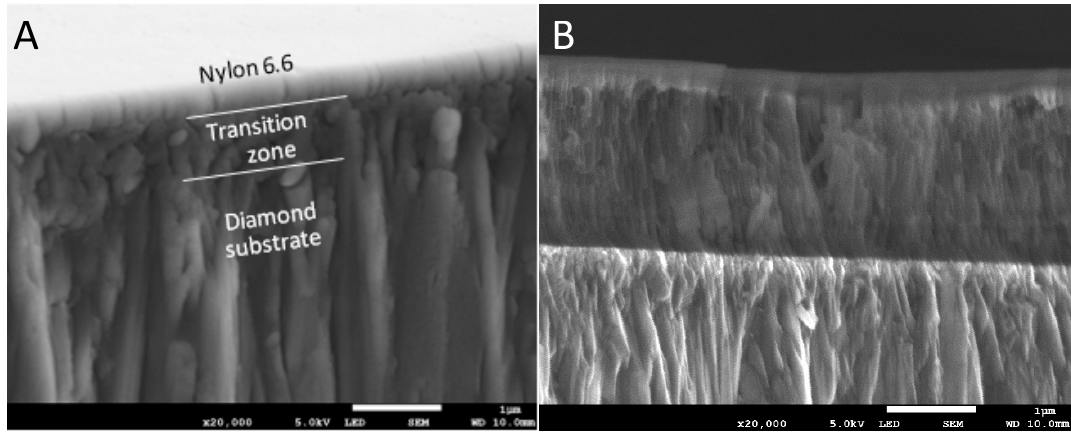
Figure 10. Structure of a cross-section of a 500 nm nylon coating—( A ), and a 2000 nm nylon coating—( B ) on a diamond substrate.